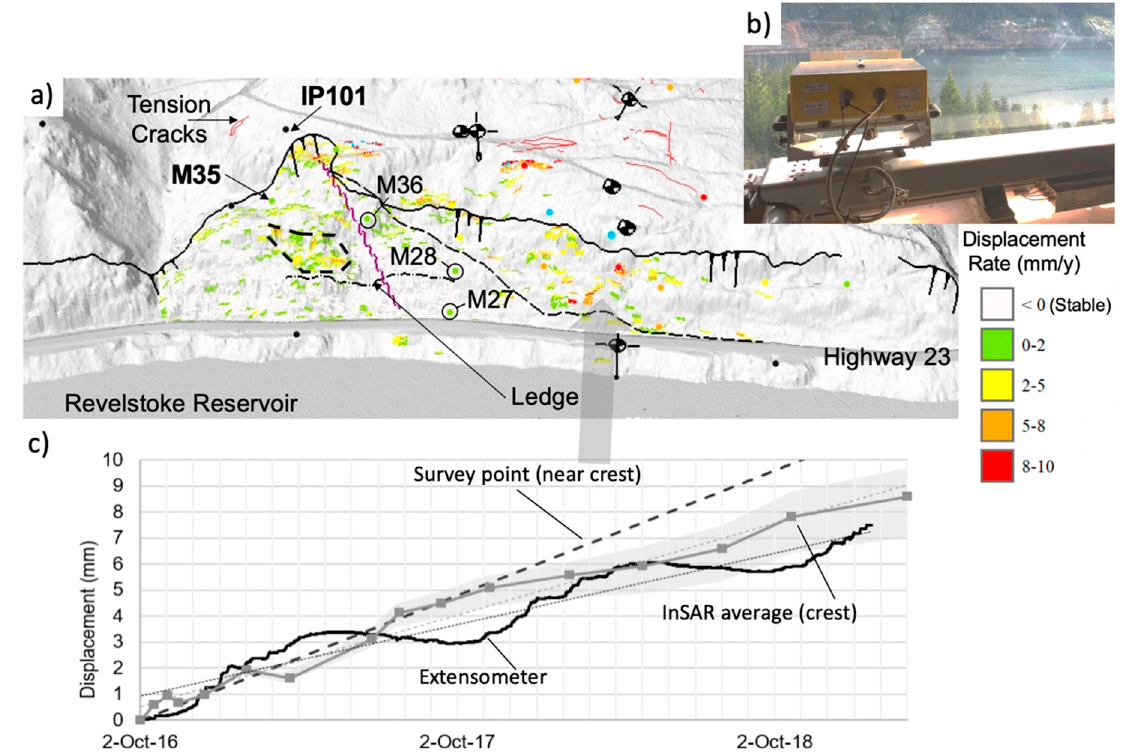
Figure 11. GB-InSAR displacement rate in the LOS at the Checkerboard Creek rock slope; crest of exposed rock face is shown with solid dark line, boundary of active deformation is shown in dark dashed line ( a ). View of the radar system looking towards the slope ( b ). D-InSAR average LOS displacement results for the active crest of the exposed rock face compared against a survey point and an extensometer located near the crest of the exposed rock face ( c ). Adapted from [53].